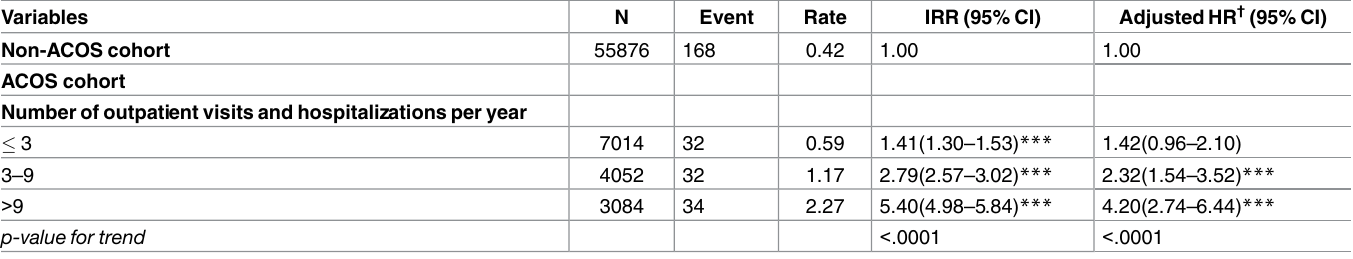
ratio 0.5; p = 0.02) used these steroids > 6 months prior to the PE event; this protective effect of PE in line with our findings [38]. Anti-inflammatory drugs, particularly ICSs [33], are the mainstay of treatment for asthma or AE of COPD cohort [33]. ACOS is also a systemic inflammation disease, for which ICSs are usually applied in treatment [39] The higher frequency of PE among ACOS patients receiving more medical servicesaccords with this finding. Steroids-induced hypercoagulability has reported for several years; however it remains con- troversial whether the use of steroids or the underlying disease itself contributes to the hyperco- agulable state [15]. The present study highlights the role of PE in ACOS cohort; the patients who used steroids may have had a lower risk of PE than those who did not. Steroids use may reduce hypoxeamia [37,39], thus patients receiving steroids may have the less risk of hypercoa- gulation [28]. However, it may also induce the prothrombotic state, irrespective of the dose, the risk of PE may be higher in these patients with steroids use, especially during the first month of exposure [40]. Determining the appropriate steroids dosage and a means of shorting the duration of steroid use for the ACOS cohort with incidental PE, while avoiding PE, war- rants randomized control study. Table 5. The adjusted hazard ratioof pulmonary embolismassociated withnumber of outpatient visitsand hospitalizationsper year due to COPD or asthmaexacerbation.